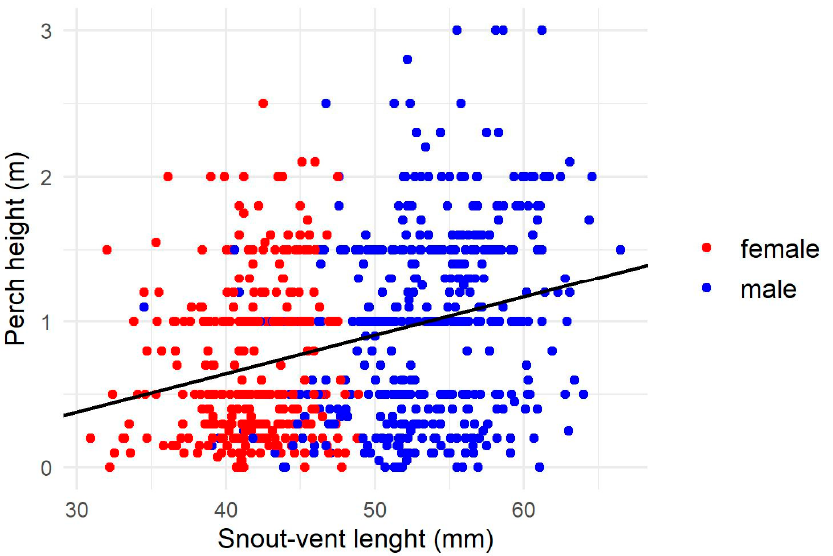
Figure 3. Relationship between snout-vent length and perch height in Anolis homolechis . The solid black line indicates linear regression.